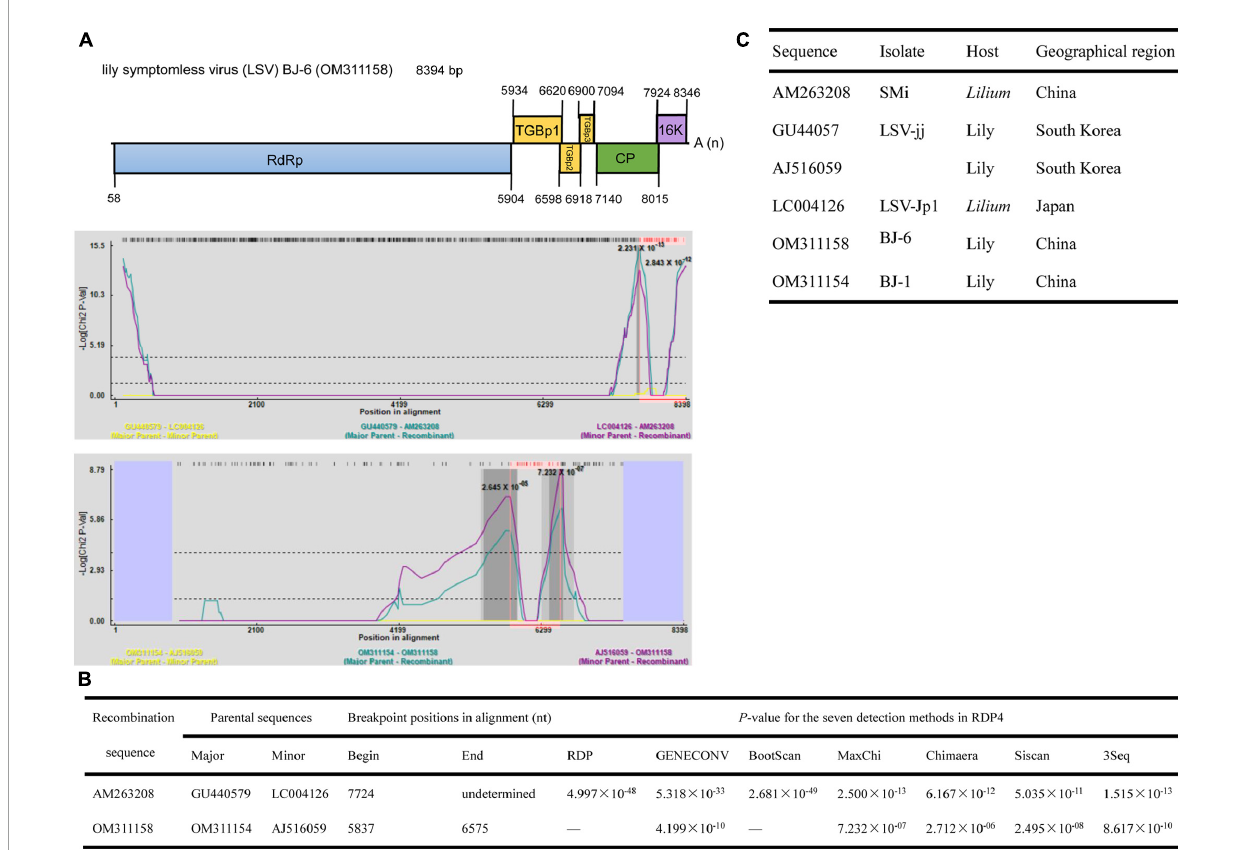
FIGURE8 Recombination in the genomic sequences of LSV analyzed using RDP4. (A) Schematic representation of the predicted recombinant LSV BJ-6 and the MaxChi plots of the two recombinants detected by the RDP4 software. (B) The relevant information of two predicted recombination events of LSV genomes. (C) The hosts and geographical regions of major and minor parents of the three LMoV recombinants. Major parent, parent contributing larger fraction of sequence; minor parent, parent contributing smaller fraction of sequence; unknown, only one parent and a recombinant need be in the alignment for a recombination event to be detectable. The sequence listed as unknown was used to infer the existence of a missing parental sequence. —, no significant. P -value was recorded for this recombination event using this